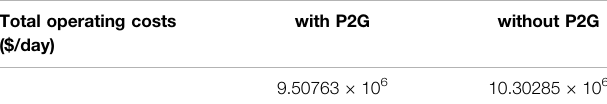
TABLE 3 | Comparison of total operating costs with or without